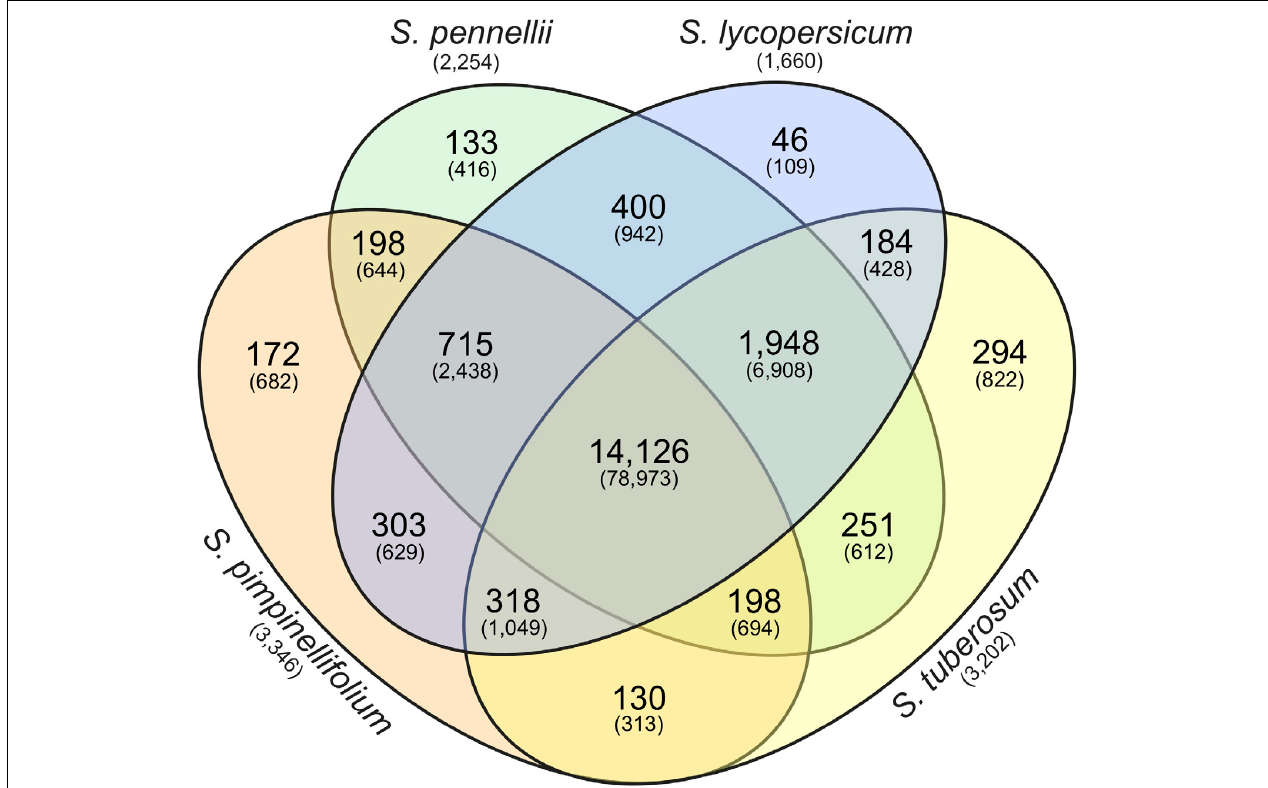
FIGURE 2 | Identification of orthologous gene clusters in S. pimpinellifolium , S. pennellii , S. lycopersicum , and S. tuberosum . The Venn diagram represents the number of protein-coding genes and gene clusters shared between, or distinct to, the indicated species. The number in each sector of the diagram indicates the number of homologous clusters and the numbers in parentheses indicate the total number of genes contained within the associated clusters. The numbers in parentheses below the species names indicate the number of species-specific singletons (genes with no homologs).